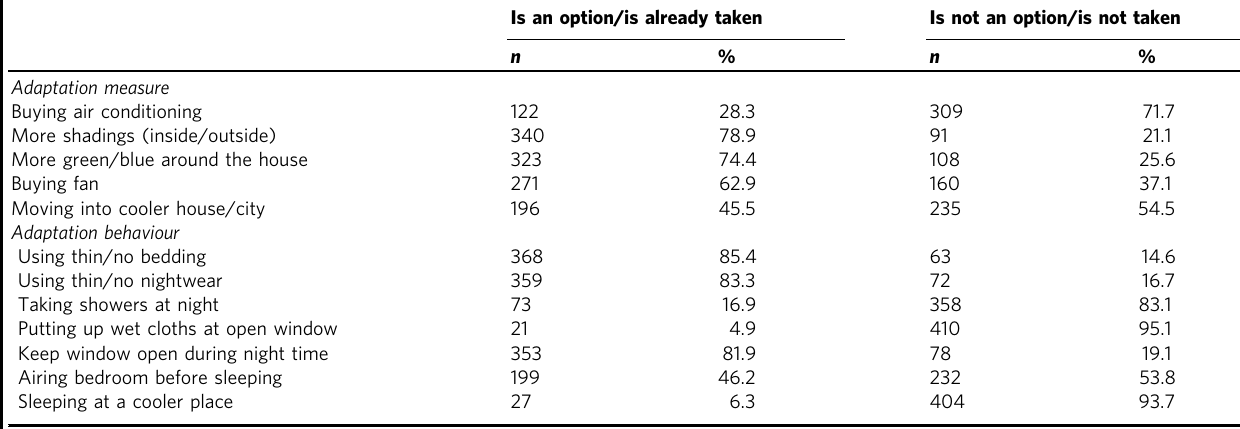
Table 2 Overview of heat adaptation measures and behaviour.